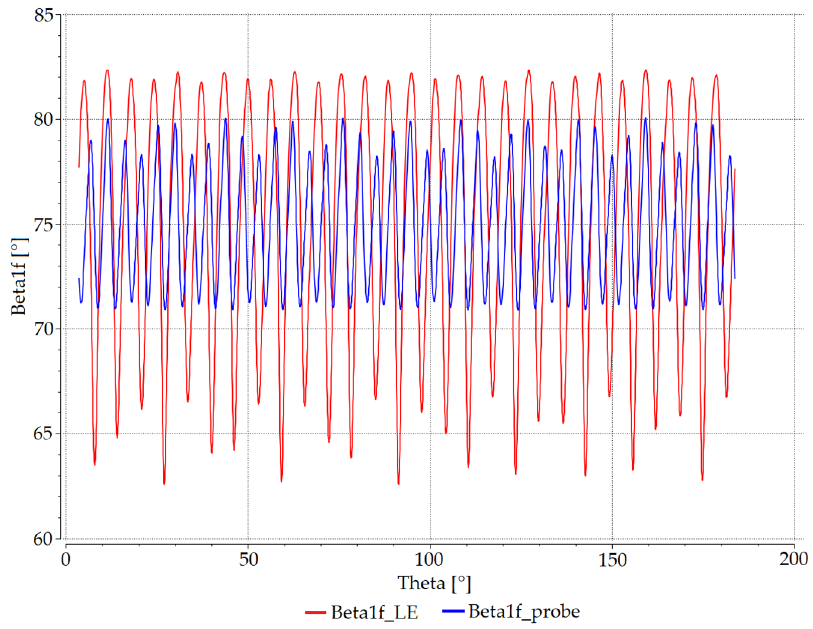
Figure 11. Unaveraged input relative velocity angle distributions at the bucket leading edge plane and pneumatic probe plane.